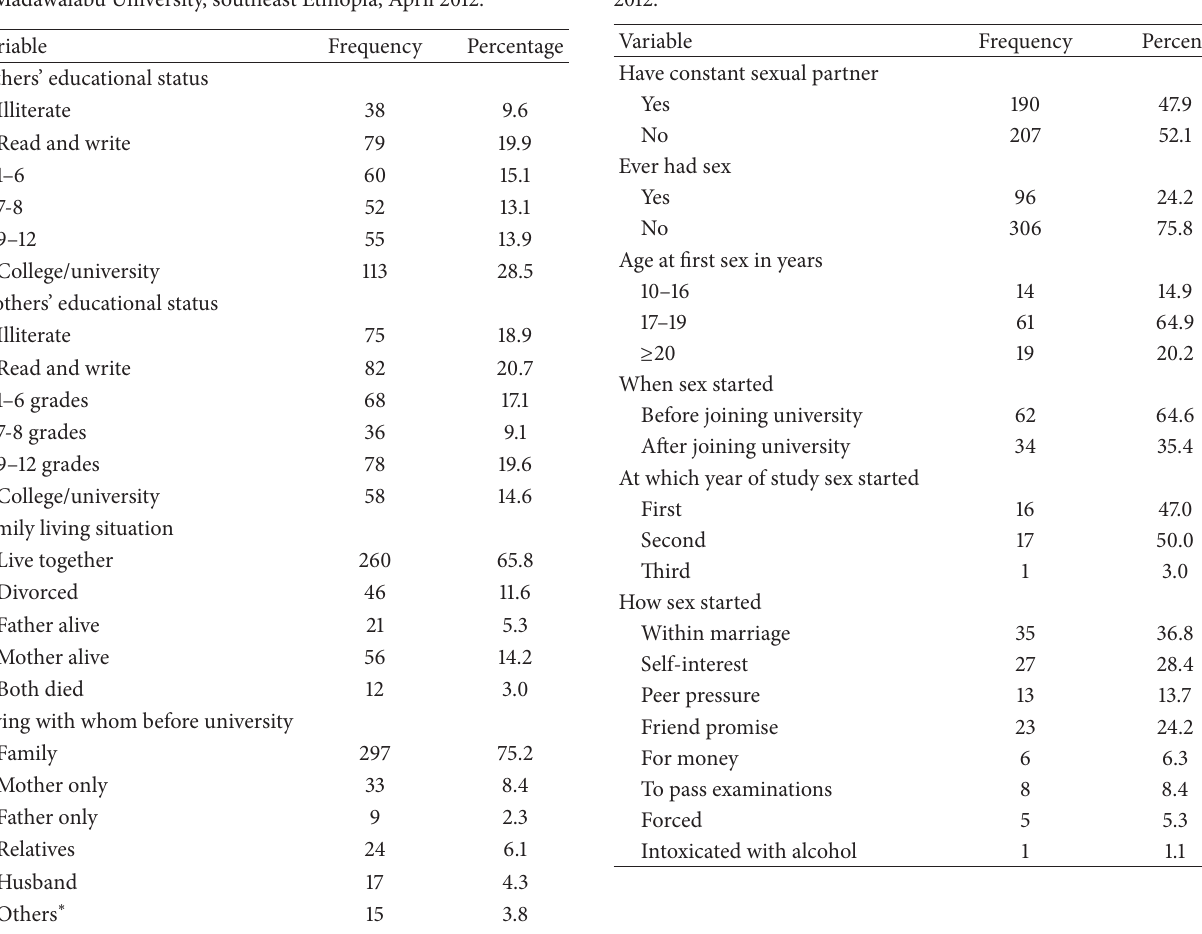
Table 3: Sexual history and characterises of sexual